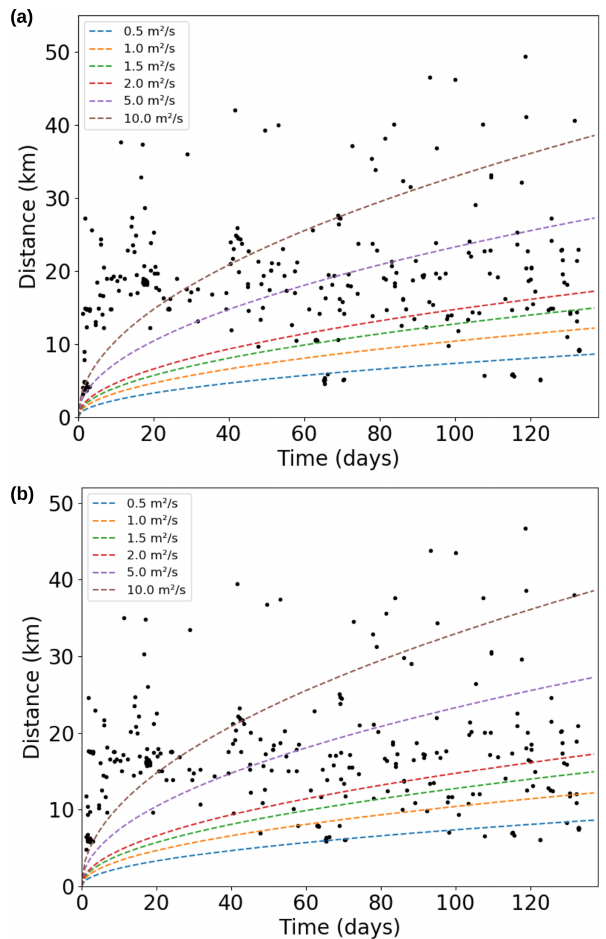
Figure 8. Time–distance plots of latent seismicity from 28 March to 6 August 2020. (a) Distance of measured events from Well A (Fig. 5b) and time zero taken as the last day of injection at this well prior to lockdown (27 March 2020). (b) Distance of mea- sured events from Well B (Fig. 5b) and time zero taken as the last day of injection at this well prior to lockdown (27 March 2020). Representative diffusion curves associated with hydraulic fracturing and wastewater injection (Goebel et al., 2017; Shapiro and Dinske, 2009) are shown. The events during quiescence in the KSMMA can- not be successfully modelled using pore pressure diffusion suggest- ing it cannot be a primary mechanism for generating this